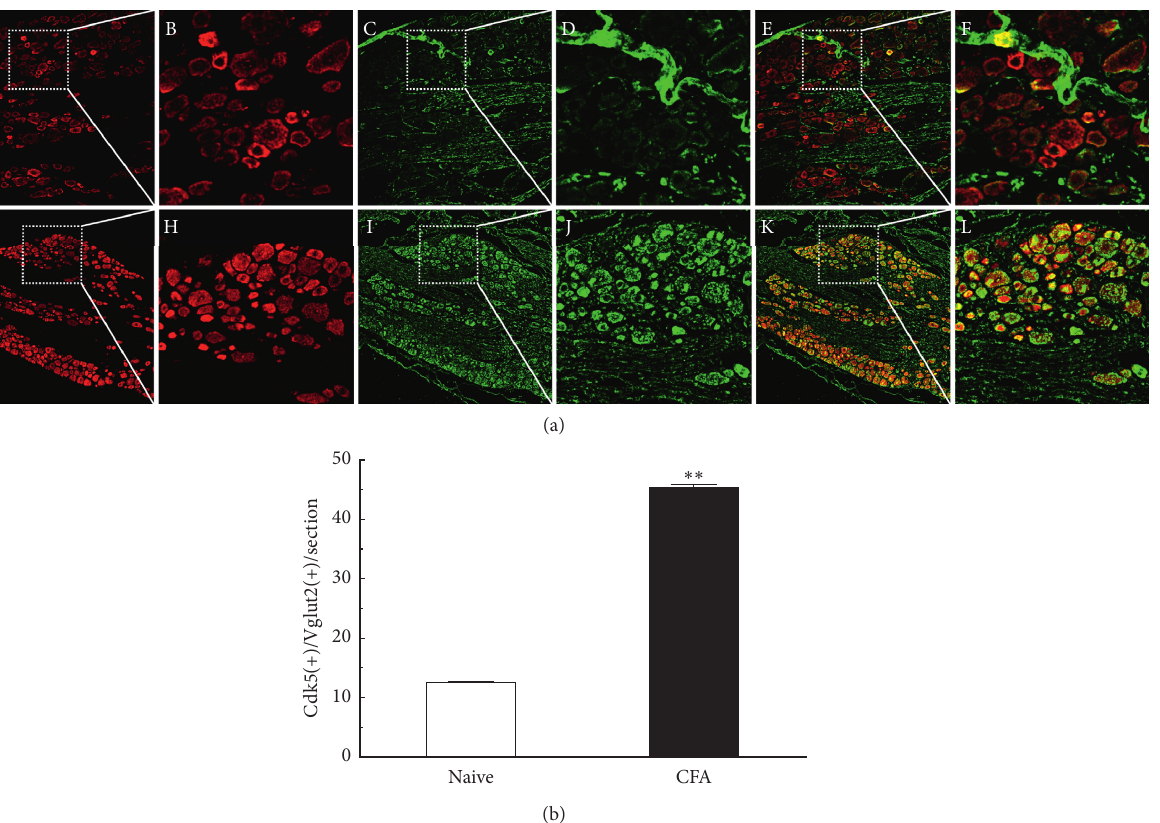
Figure 1: Coexpression of Cdk5 and VGLUT2 was increased in the DRG neuronal cells. Double-immunofluorescence staining for Cdk5 (red) and VGLUT2 (green). Compared with the control group by intraplantar injection of saline (A–F), the coexpression of Cdk5 and VGLUT2 was significantly increased in DRG neurons in the group on day 1 following intraplantar injection of CFA (G–L). Data shown represent mean ± SEM; ∗∗ P < 0 . 01; n �